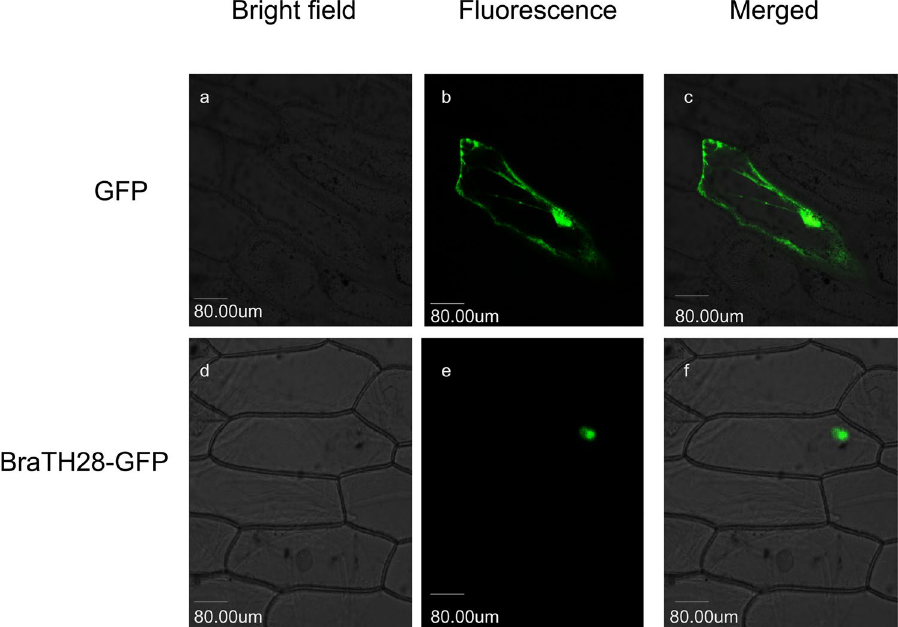
Figure 9. Nuclear localization of BraTH28 in onion epidermal cells. Onion epidermal cells were transfected by 35S::GFP ( a–c ) or 35S:: BraTH28 -GFP ( d–f ) and photographed under a confocal microscope at 488 nm after 48 h ( a,d ). ( b and e ) are respectively the transmission image of ( a and d ). ( c and f ) are merged images of ( a and b or d and e )